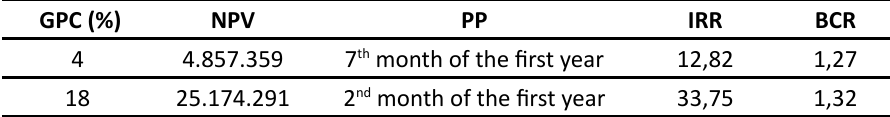
Table 2: Result of analysis of financial from GPC